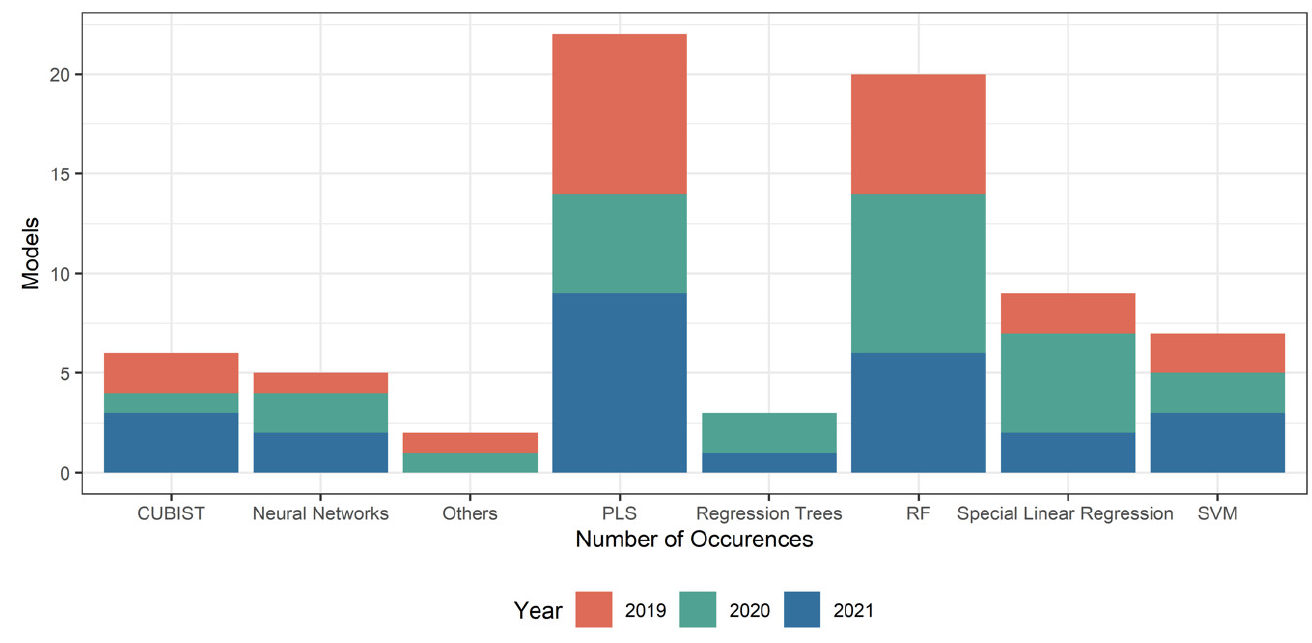
Figure 5. Evolution of regression model usage in the period 2019–2021. Neural networks includes both artificial and convolutional neural networks; others include elastic network and k-nearest neighbor algorithms; regression trees includes gradient boosting, and C4.5 algorithms; while special linear regressions refer to stepwise multiple regression, RIDGE, and LASSO algorithms.